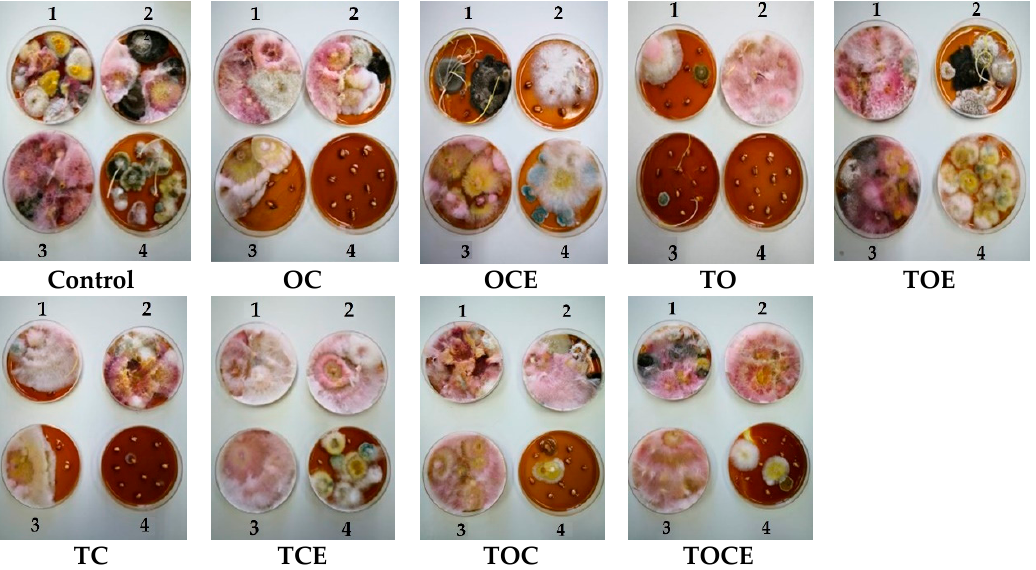
Figure 2 . The appearance of mycelium development after exposure to EOs and emulsions for 7 days of treatment (1), 14 days (2), 21 days (3), and 28 days (4). OC—binary mixture of oregano and cori ‐ ander EOs; OCE—binary emulsion of oregano and coriander EOs; TO—binary mixture of thyme and oregano EOs; TOE—binary emulsion of thyme and oregano EOs; TC—binary mixture of thyme and coriander EOs; TCE—binary emulsion of thyme and coriander EOs; TOC—tertiary mixture of oregano, coriander, and thyme EOs; TOCE—tertiary emulsion of oregano, coriander, and thyme EOs.